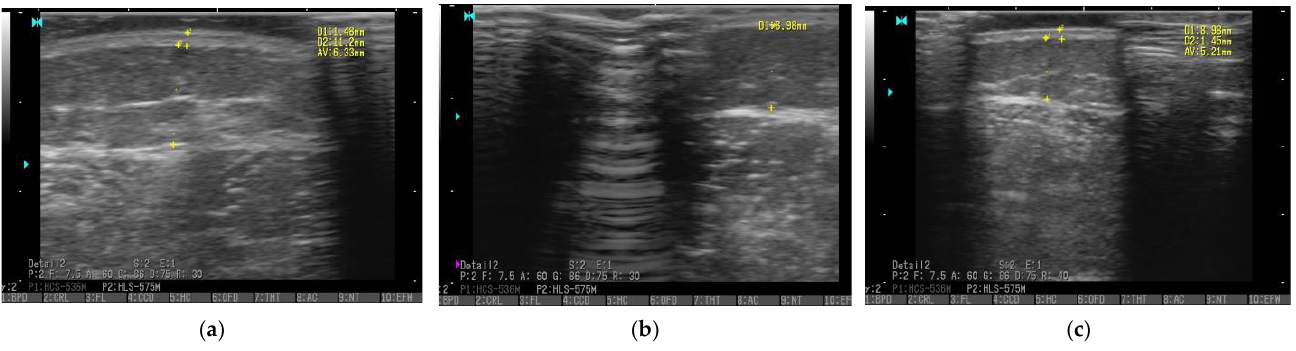
Figure 4. Thickness of adipose tissue measured by ultrasonography at ½ length on the side of the shin on the right leg in Patient 2B at baseline ( a ), after 4 weeks ( b ), after 6 weeks ( c ). The thickness of adipose tissue is marked with † signs, 1 and 2 measurement stand for the thickness of the skin.